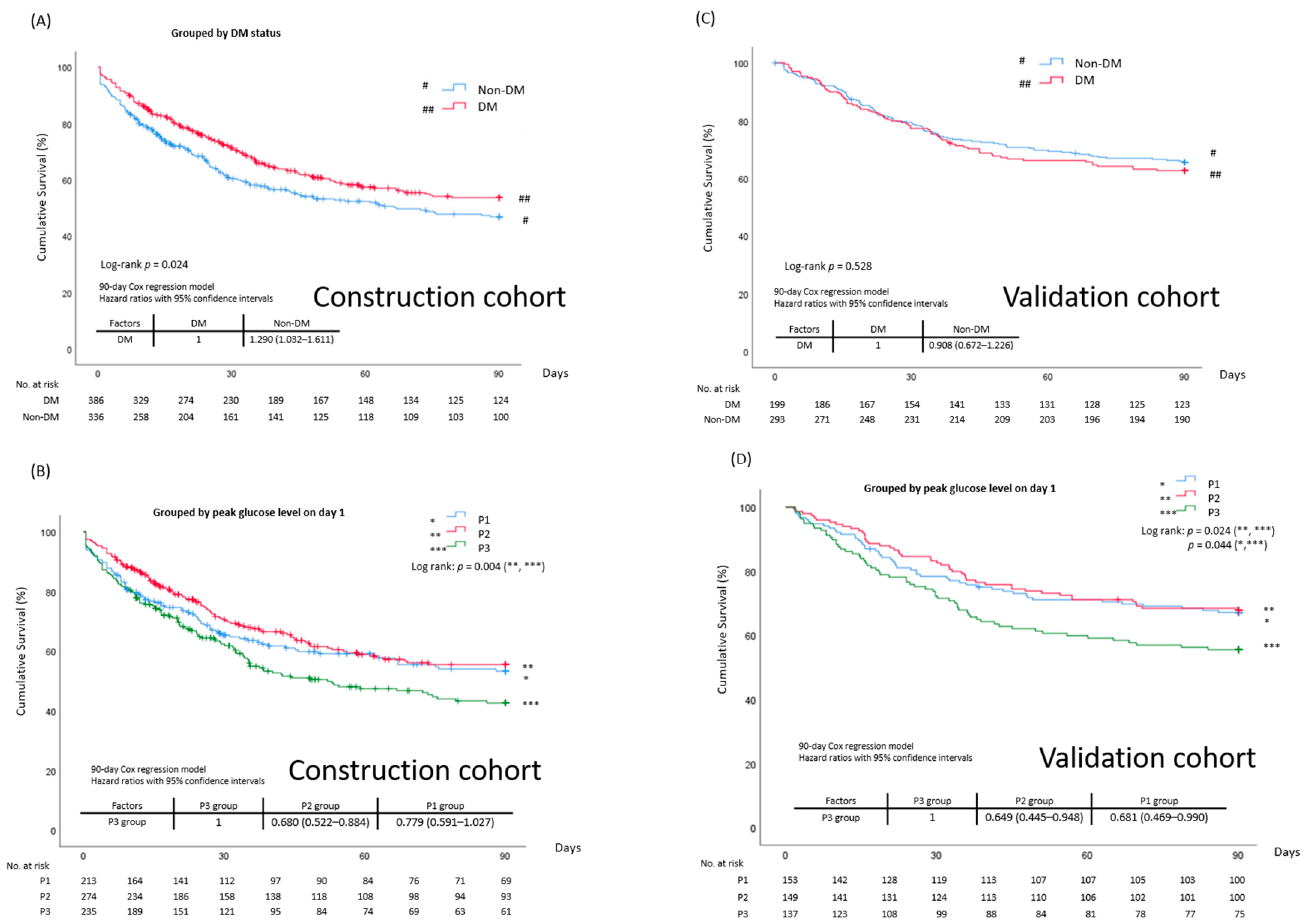
Figure 2. Ninety-day survival curves. ( A ) Between DM and non-DM in construction cohort; ( B ) among P1, P2, and P3 groups by peak glucose levels on day one in construction cohort; ( C ) between DM and non-DM in validation cohort; ( D ) among P1, P2, and P3 groups by peak glucose levels on day one in validation cohort. # (non-DM), ## (DM), * (P1 group), ** (P2 group), *** (P3 group). Kaplan-Meier estimates of 90-day survival according to stratification. Hazard ratios between or among groups, obtained using Cox regression models, are also